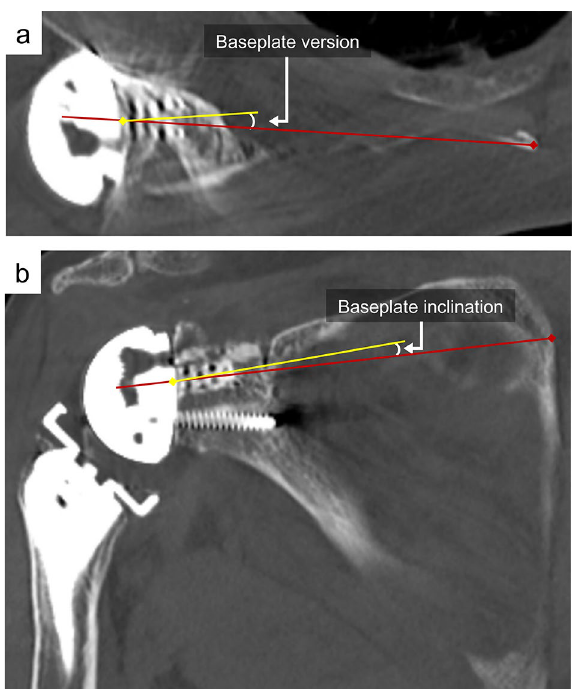
Figure 4. Measurement of glenoid component alignment including version and inclination. ( a ) Baseplate version was defined as the angle between Friedman’s axis and the axis of the central cage. ( b ) Baseplate inclination was defined as the angle between Friedman’s axis and the axis of the central